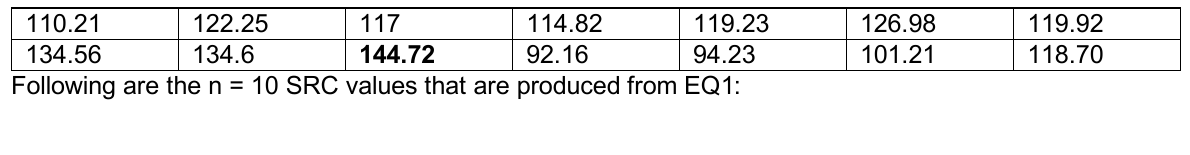
Table 1: CMI: S&P500 Panel